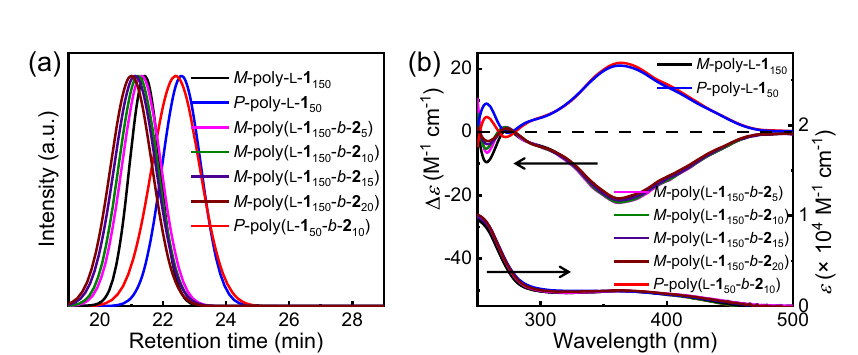
Fig.2|SECtraces,CDandUV – visspectraofcatalysts. Sizeexclusionchromatograms( a ),andCDandUV – visspectra(a.u.istheabbreviationofarbitraryunits)( b )ofthe isolated single-handed helical polyisocyanides. The CD and UV – vis spectra were recorded in THF with 0.2mg/mL at